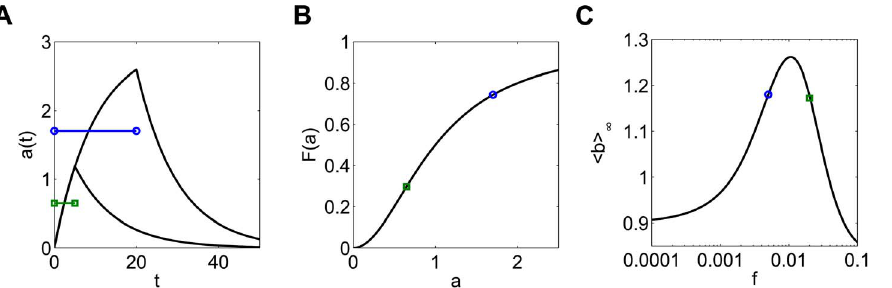
Figure 6. Adding a linear component to the b-model results in frequency sensitivity to duration compensated signals. ( A ) The mean value of a(t) during the on and off phases of the pulsatile signal varies with pulse frequency. In particular, the mean value during the on-phase of pulses (colored horizontal lines) decreases as duration decreases, thereby allowing the relevant portions of the nonlinearity of the production rate function F(a) to be sampled by the input signals ( B ). ( C ) For a sigmoidal production rate function, F(a)=a 2 /(a 2 + 1), this leads to a bell shaped response. A 0 =3 and d 0 =10 at frequency f 0 =0.01.